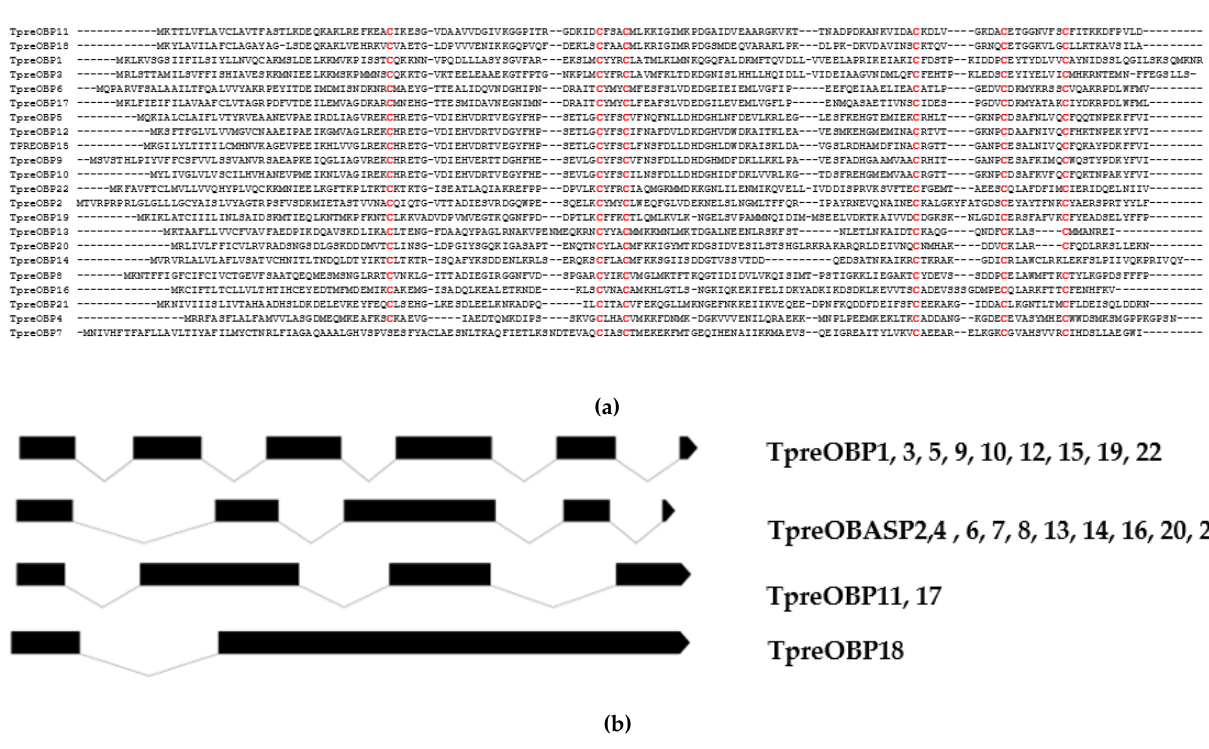
Figure 2. The alignment of 22 TpreOBP amino acid sequences ( a ) and their intron/exon gene structures ( b ). The six conserved cysteines are highlighted by red colour. Black blocks represent exons, while the lines represent introns.